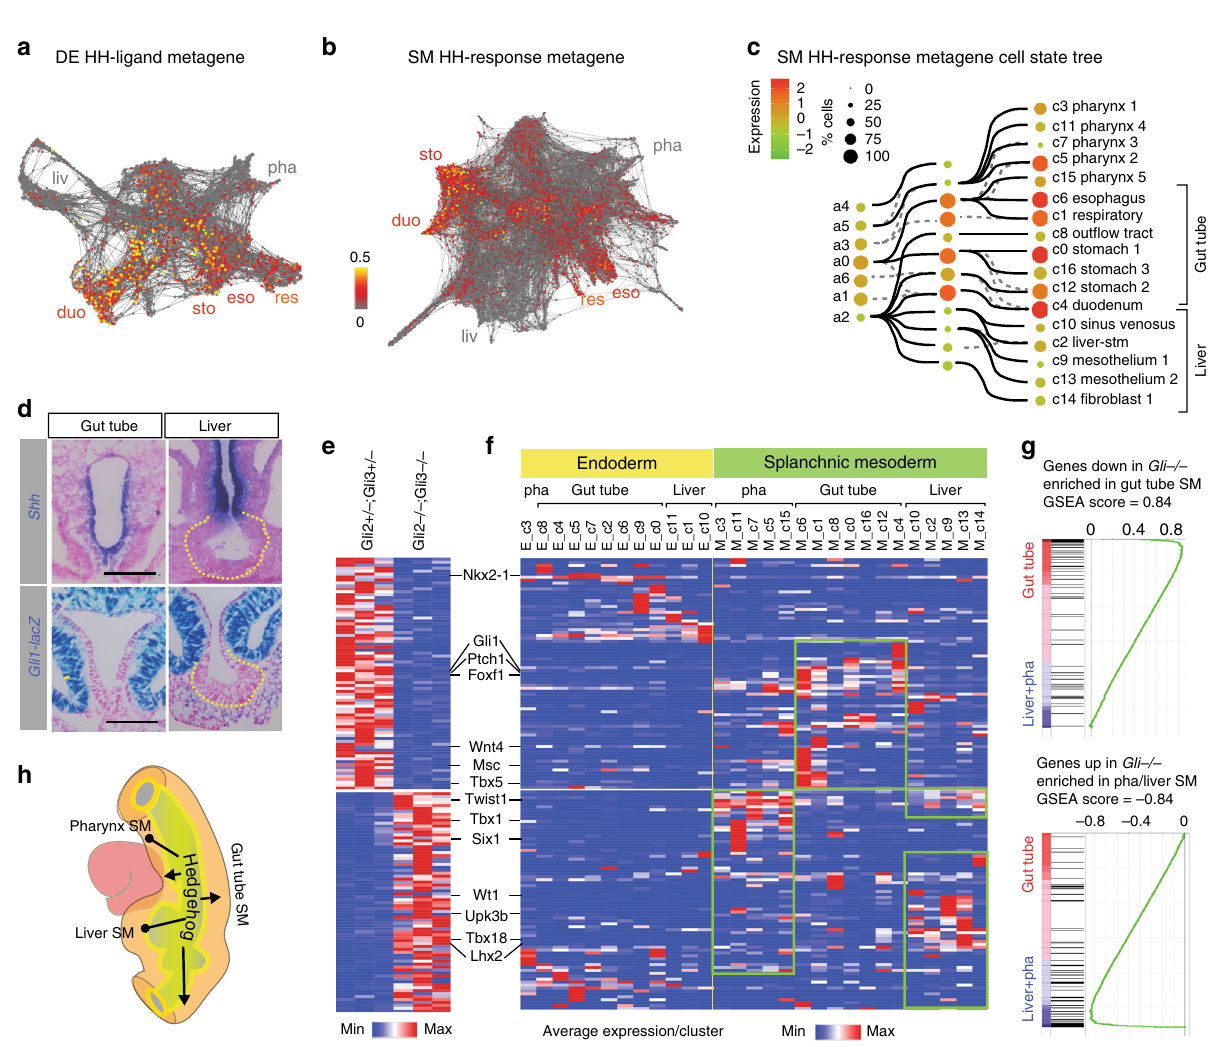
Fig. 6 Genetic test of the signaling roadmap revealed that HH promotes gut tube versus liver mesenchyme. a , b SPRING visualization of a the HH ligand – metagene expression in DE cells and b HH-response – metagene expression in SM cells. The color scale shows the normalized expression in each cell. c The normalized HH response – metagene expression projected onto the SM cell-state tree, showing low HH activity in the liver and pharynx SM but high activity in the gut tube mesenchyme. d Shh is expressed in the gut tube epithelium but not in the hepatic epithelium (outlined). n = 5/5 embryos. Gli1- lacZ , a HH-response transgene, is active in the gut tube mesenchyme but not in the liver stm. n = 3/3 embryos. Scale bars: 100 μ m. e . Differentially expressed genes between Gli2 − / − , Gli3 − / − and Gli2 + / − , Gi3 + / − mouse E9.5 foreguts through bulk RNA sequencing (log2 FC > 1, FDR < 5%). n = 3 embryos/genotype. f Heatmap showing the min – max row normalized average expression of HH/Gli-regulated genes (from e ) in E9.5 DE and SM single- cell clusters. g Gene set enrichment analysis (GSEA) reveals speci fi c cell-type enrichment of HH/Gli-regulated genes. h Schematic of HH activity in the